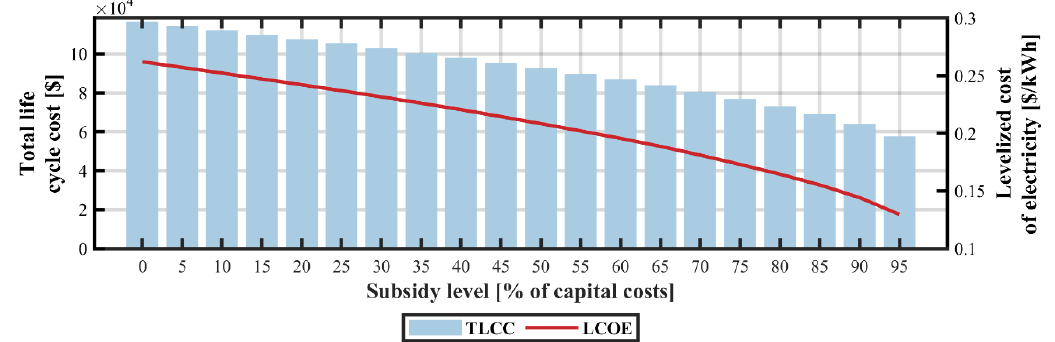
Figure 9. Simulation results of capital subsidies for renewable energy technologies. Impact on LCOE and TLCC.